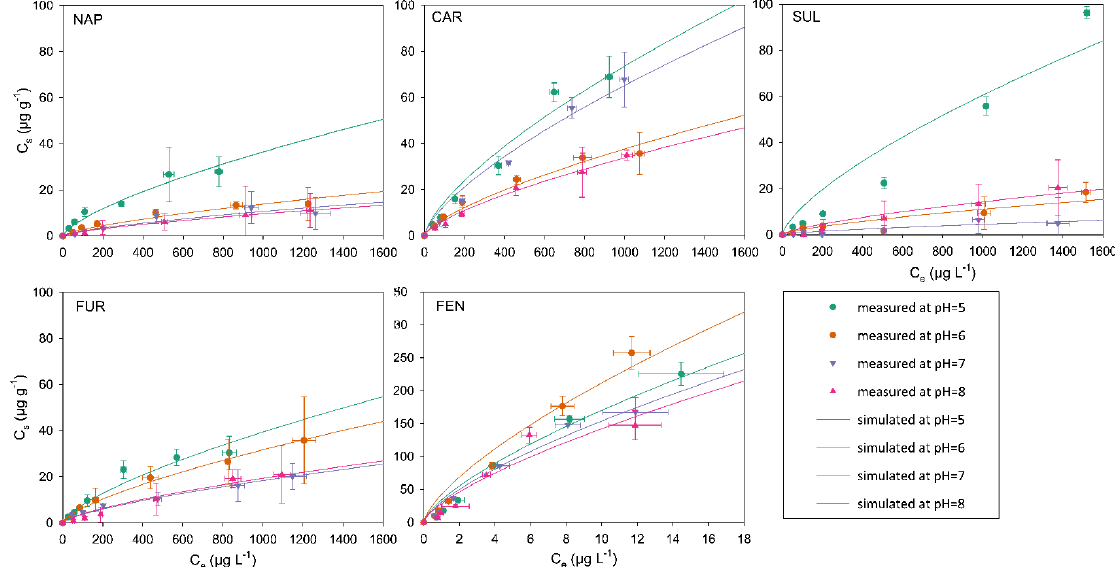
Figure 2. Sorption isotherms of pharmaceuticals to sediments under four pH conditions, with all isotherms normalized to the organic matter of the sediments. The solid points show the measured data; the solid lines represent the best fit of a theoretical Freundlich isotherm. Note the differences in axis scales.